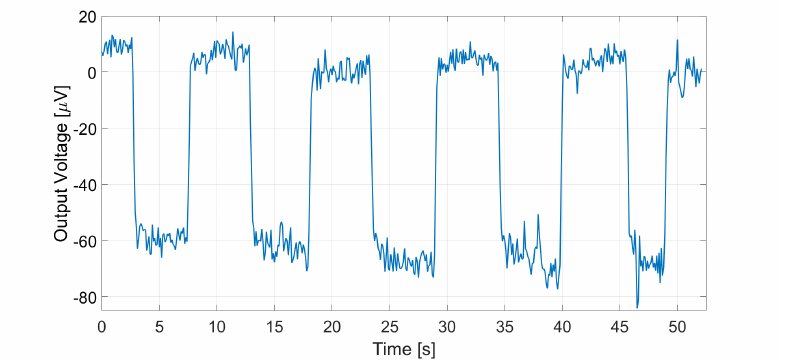
Figure 16. Measured diode–connected TMOS output in the case of a hand moved in front of the sensor at 5 cm distance.